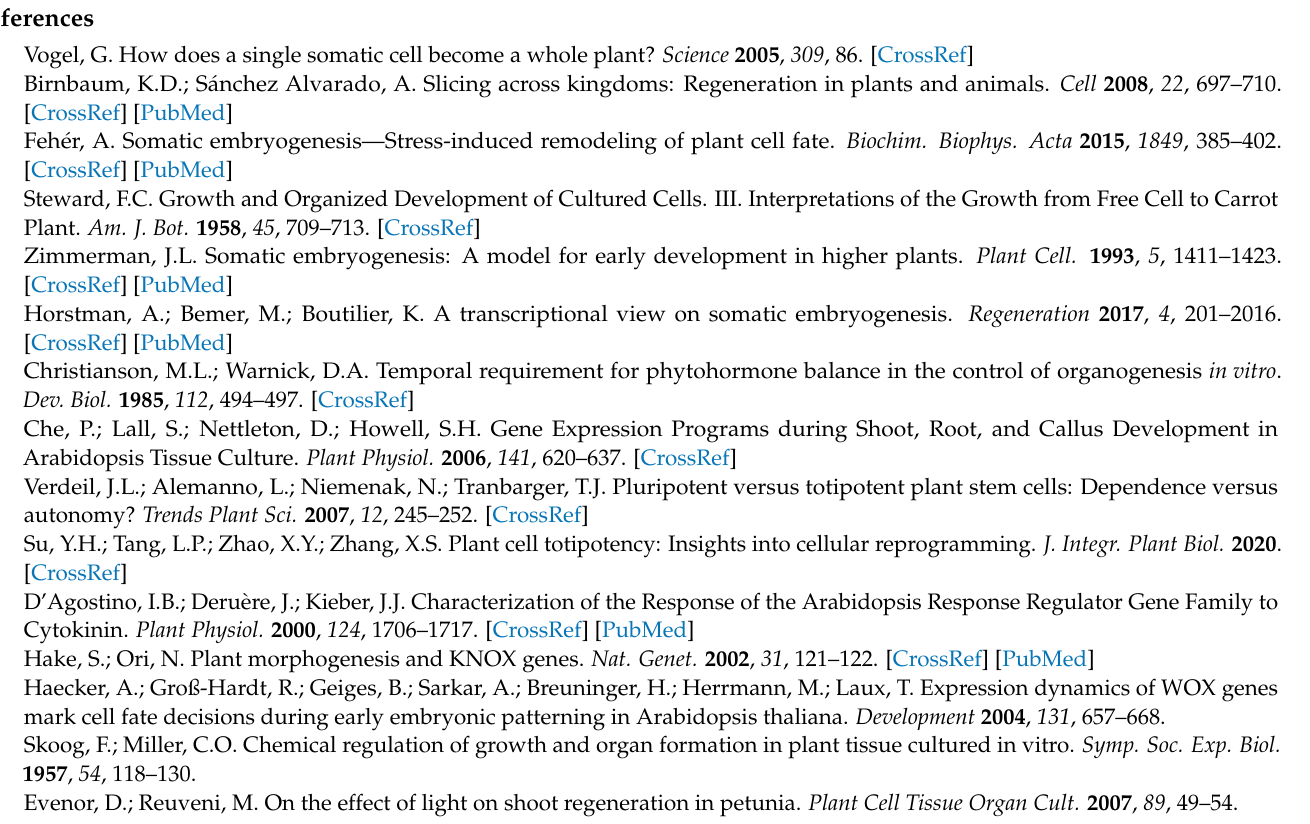
Figure S5: Transcript analyses of biological processes that upregulate at day 7 compared to day 0 of the induction of shoot regeneration. Figure S6: Transcript analyses of MADS box gene family during the 7 days compared to day 0 of the induction of shoot regeneration. Figure S7: Transcript analyses of NAC gene family during the 7 days compared to day 0 of the induction of shoot regeneration. Figure S8: Transcript analyses of histone related genes during the 7 day compared to day 0 of the induction of shoot regeneration. Figure S9: Transcript analyses of phyto-hormones signal transduction pathways at the 1 day compared to day 0 of the induction of shoot